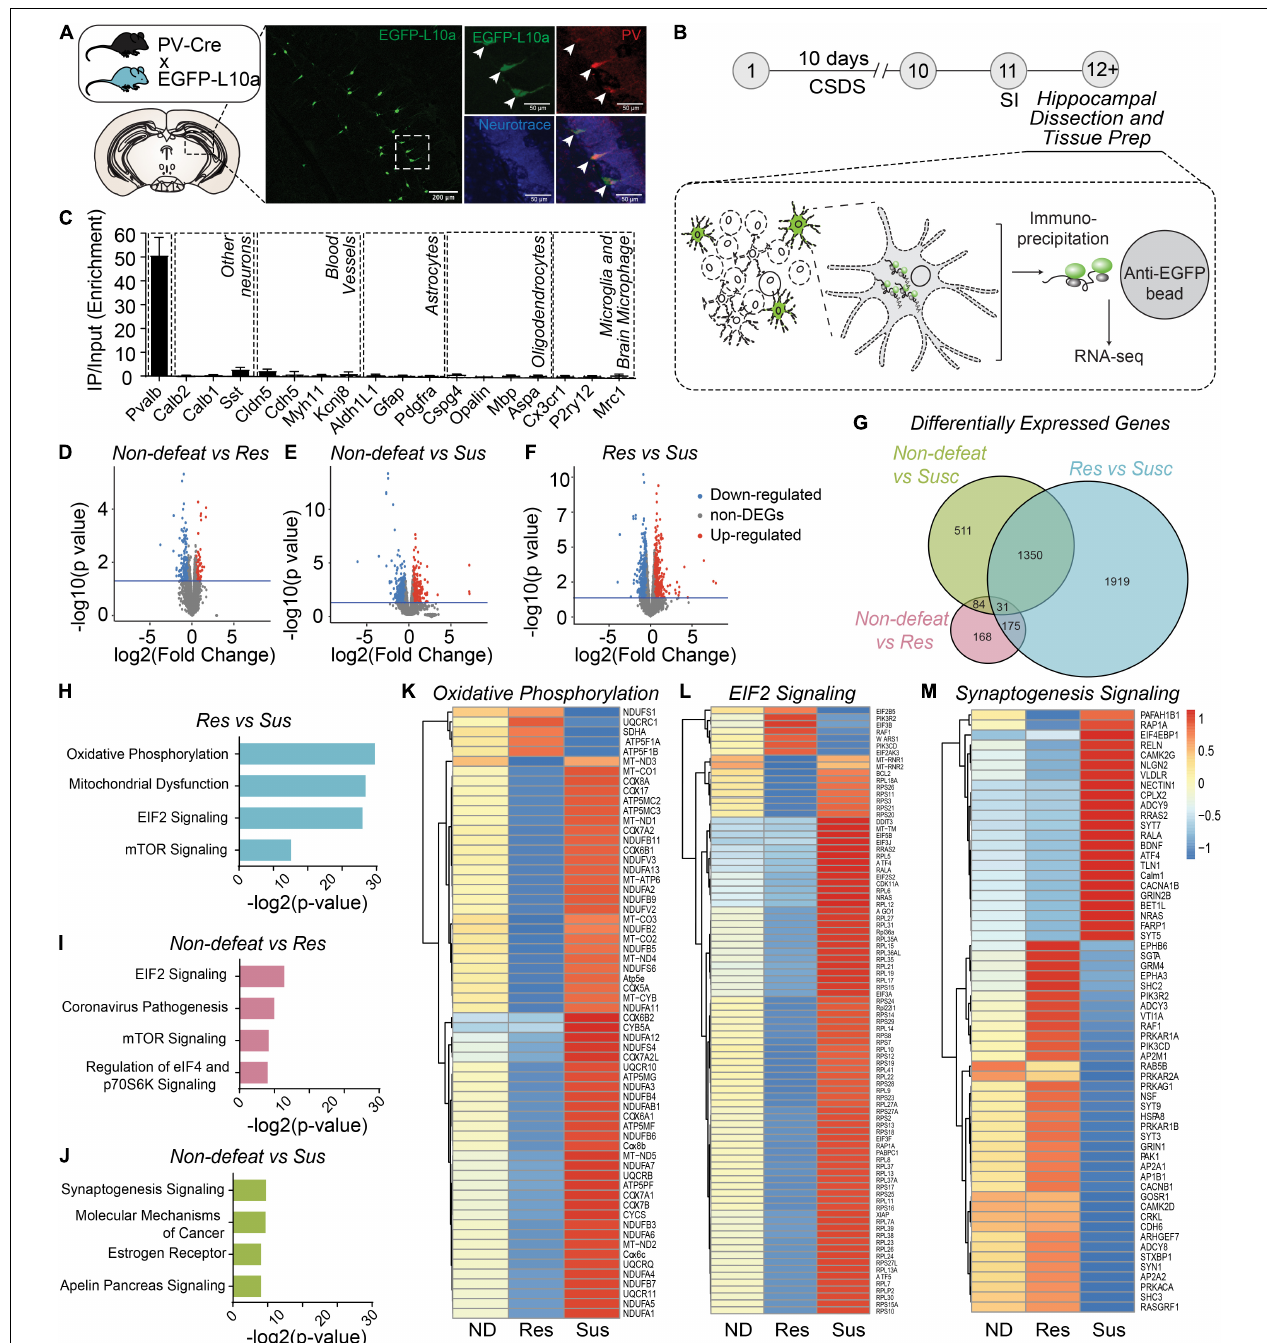
FIGURE 3 | Molecular adaptations in hippocampal PV neurons are associated with divergent behavioral consequences after CSDS. (A) Diagram of transgenic PV-specific EGFP-L10a line for TRAP. Representative images showing EGFP-L10a expression in the vDG (left image; scale bar, 200 µ m) and high magnification images of a dotted rectangular region showing selective expression of EGFP-L10a in PV neurons (right images; scale bar, 50 µ m). (B) Timeline of CSDS and subsequent hippocampal dissection, TRAP and RNAseq. (C) Enrichment of marker genes in TRAP/RNAseq data. (D–F) Volcano plots of DEGs in Non-defeated (ND) vs Res (D) , ND vs Sus (E) and Res vs Sus (F) comparisons. (G) Venn diagram for DEGs (cutoff, p < 0.05). (H–J) Top 4 pathways significantly altered in Res vs Sus (H) , ND vs Res (I) , ND vs Sus (J) comparisons. (K–M) Heat maps of DEGs in the top pathway in each comparison. Mean value of gene expression was used [(ND ( n = 4), Res ( n = 4) and Sus ( n =